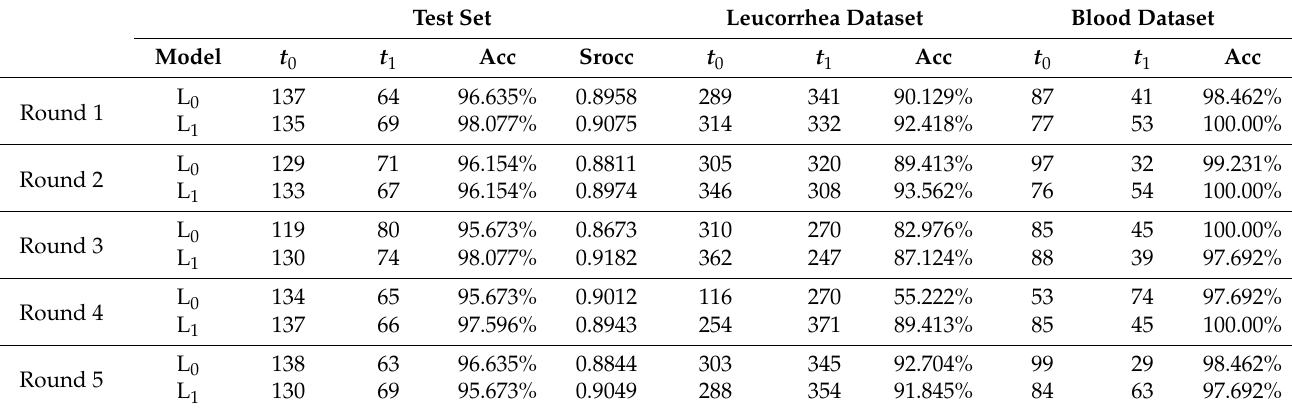
Table 2. The performance of model trained without auxiliary outputs. Test Set Leucorrhea Dataset Blood